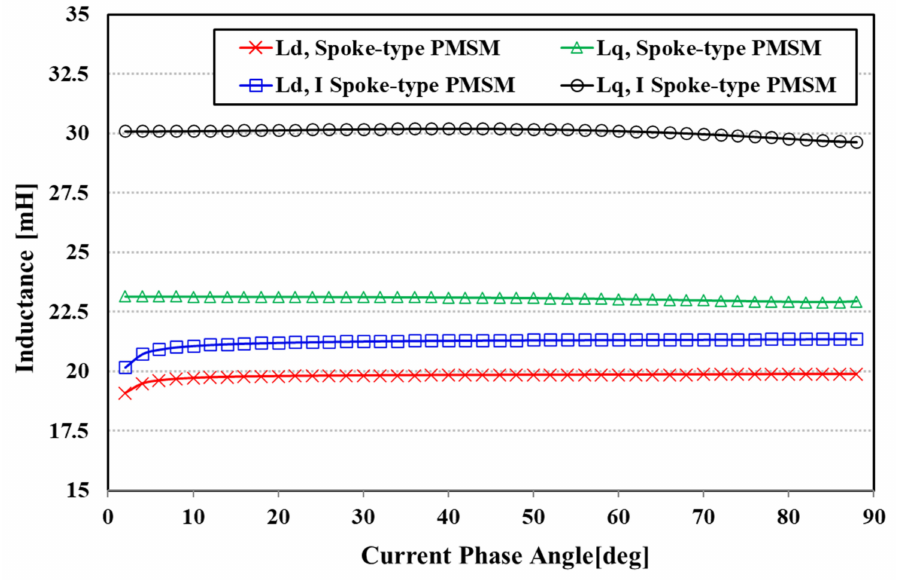
Figure 5. Comparison of d, q-axis